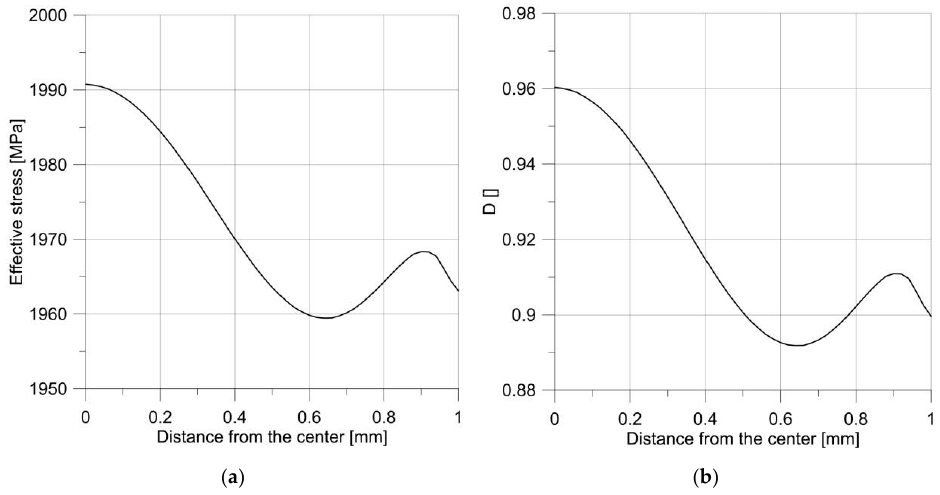
Figure 13. The distribution of effective stress ( a ) and the parameter D ( b ) just before the moment of failure of the sample, with the notch R = 2.5 mm.